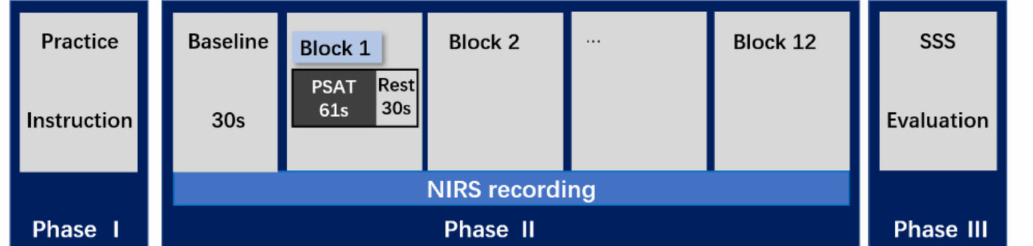
Figure 1. Experimental procedure. This study consisted of the following three phases: I: Practice phase; II: NIRS-recording phase; and III: SSS-evaluation phase. Phase II consisted of a 30 s baseline and twelve blocks, and each block consisted of 61 s PSAT task and 30-s rest. PSAT, Paced Serial Addition Test; fNIRS, functional near-infrared spectroscopy; SSS, Stanford Sleepiness Scale.